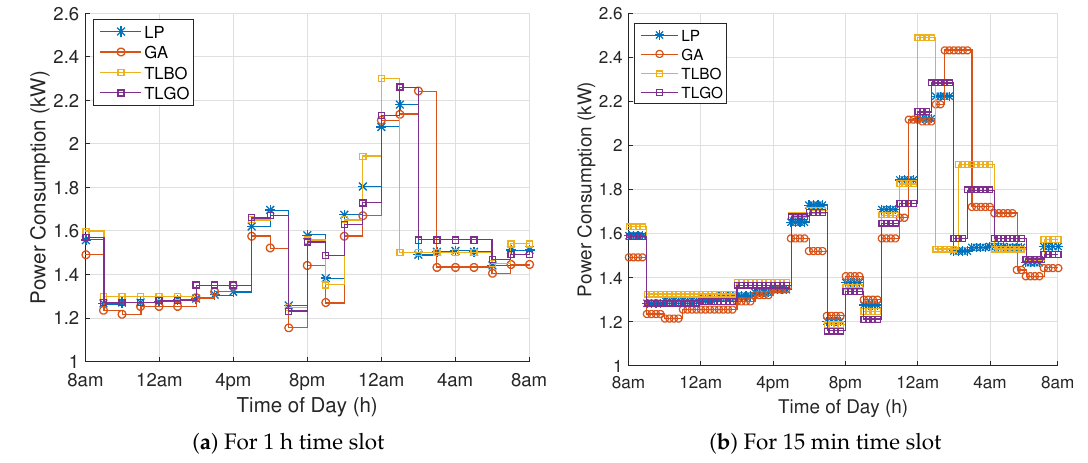
Figure 5. Power consumption of appliances under CPP.